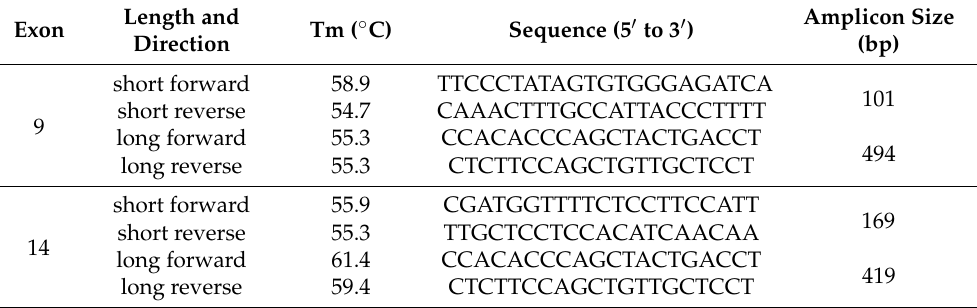
Table 3. Primer sequences used to amplify the CRISPR/Cas9 targeted regions of the BRCA1